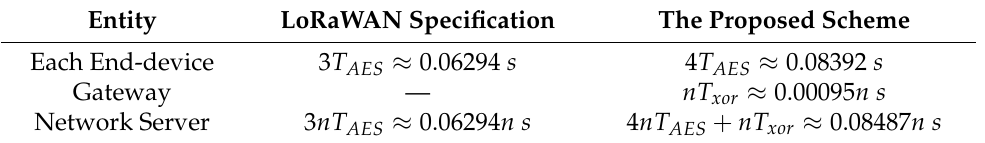
Table 4. Computation